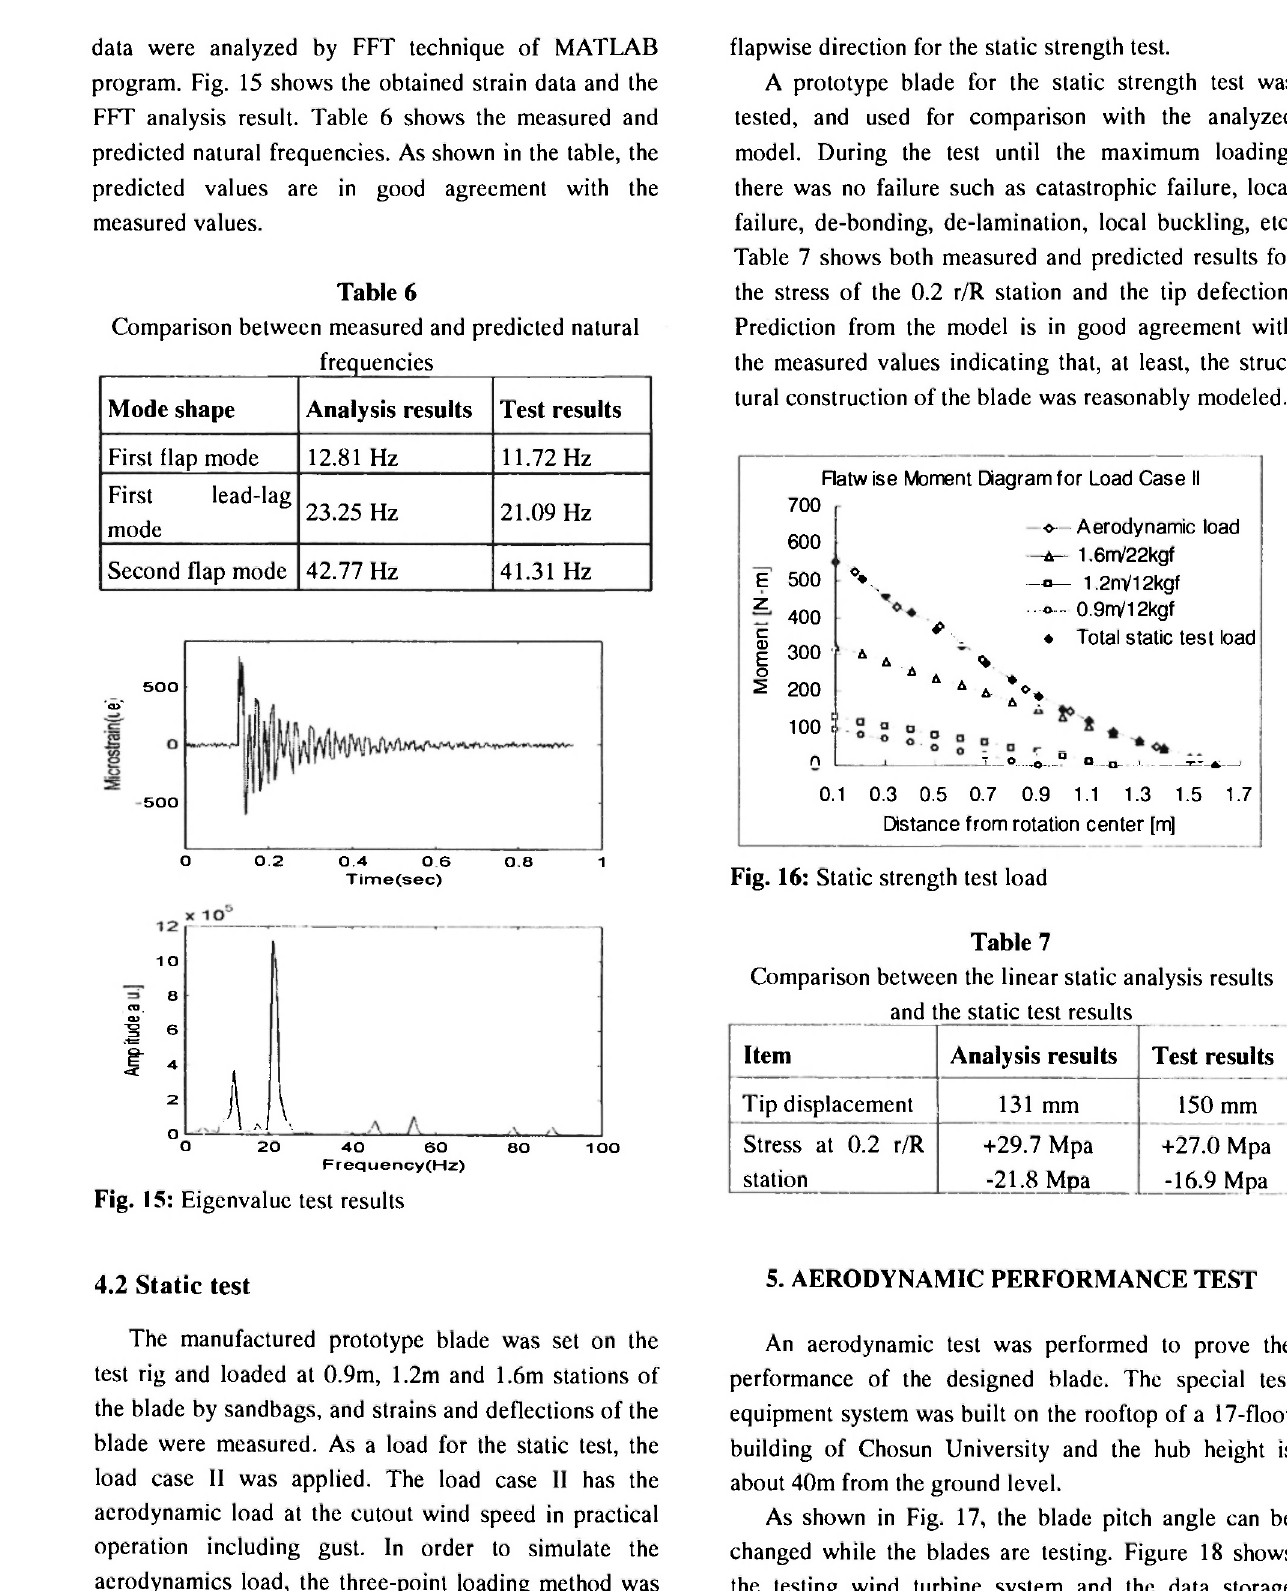
Comparison between the linear static analysis results and the static test